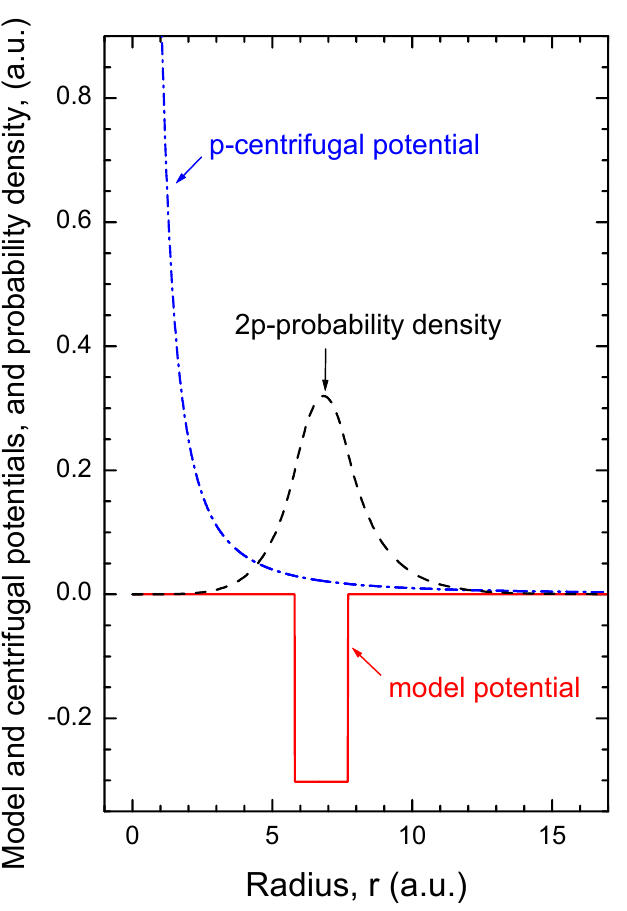
( r ) , the centrifugal potential U 60